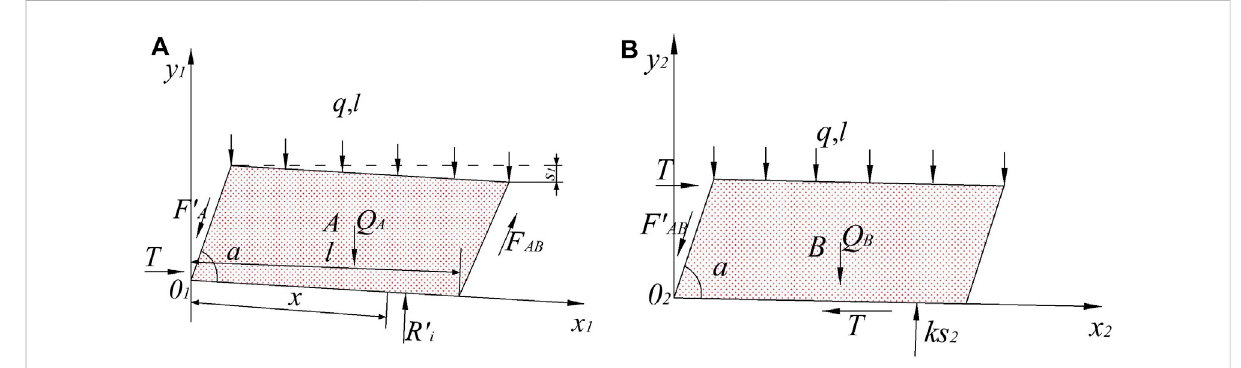
FIGURE 4 Force calculation of roof: (A) block A; (B) block